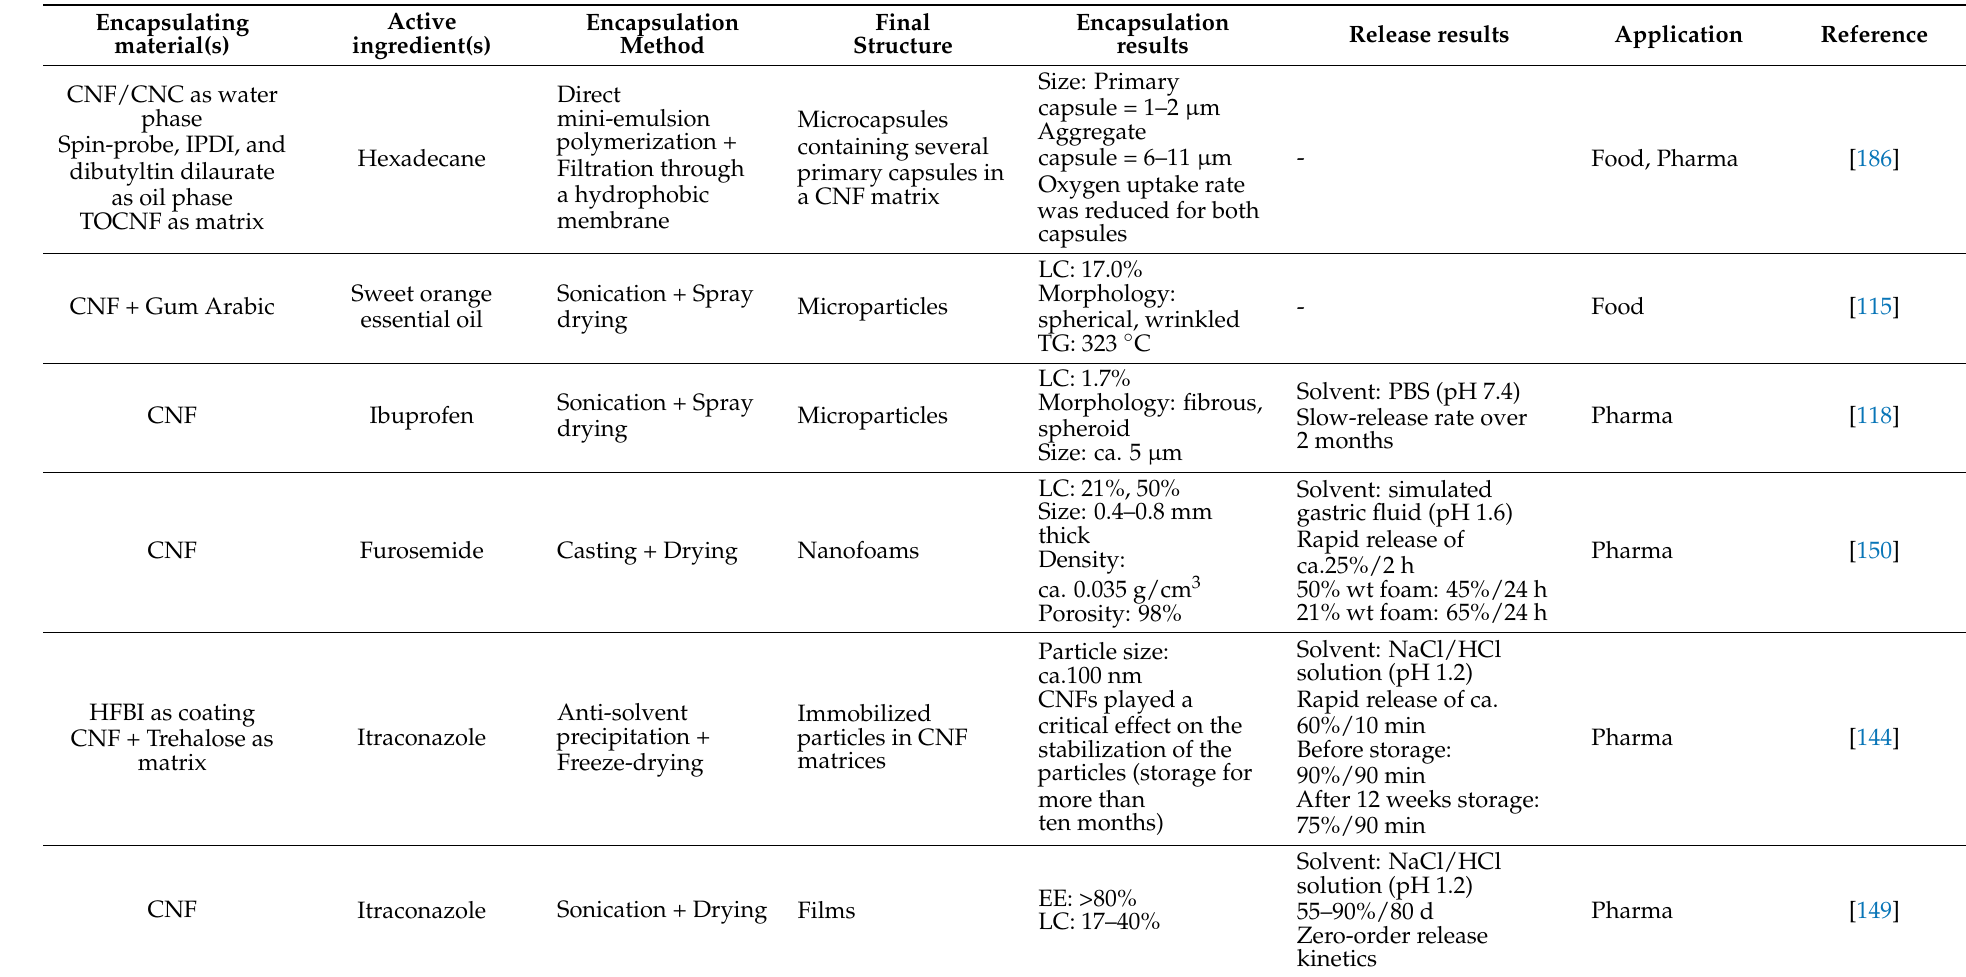
Table 4. Studies on the use of cellulose nanofibers for the encapsulation and controlled release of liposoluble